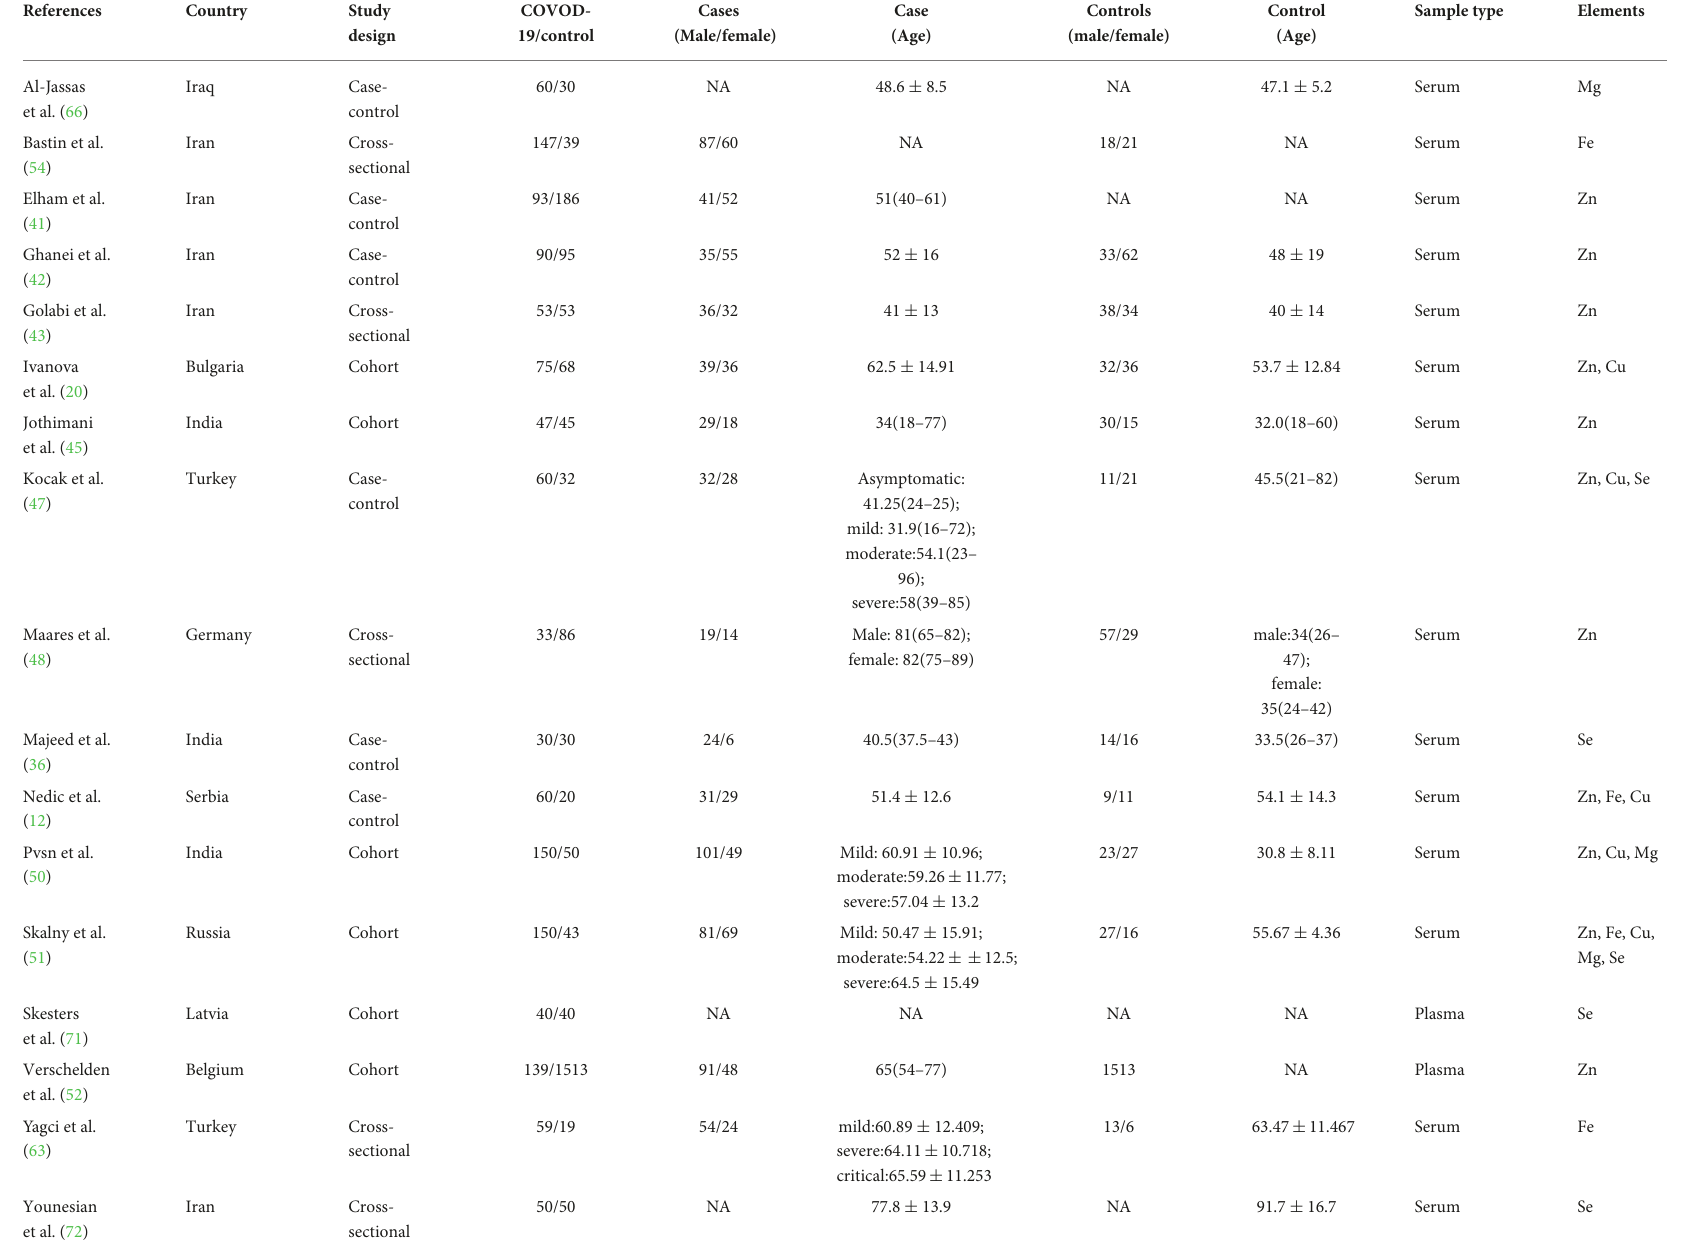
TABLE 1 The main characteristics of included studies in comparison of trace elements between COVID-19 cases and controls.